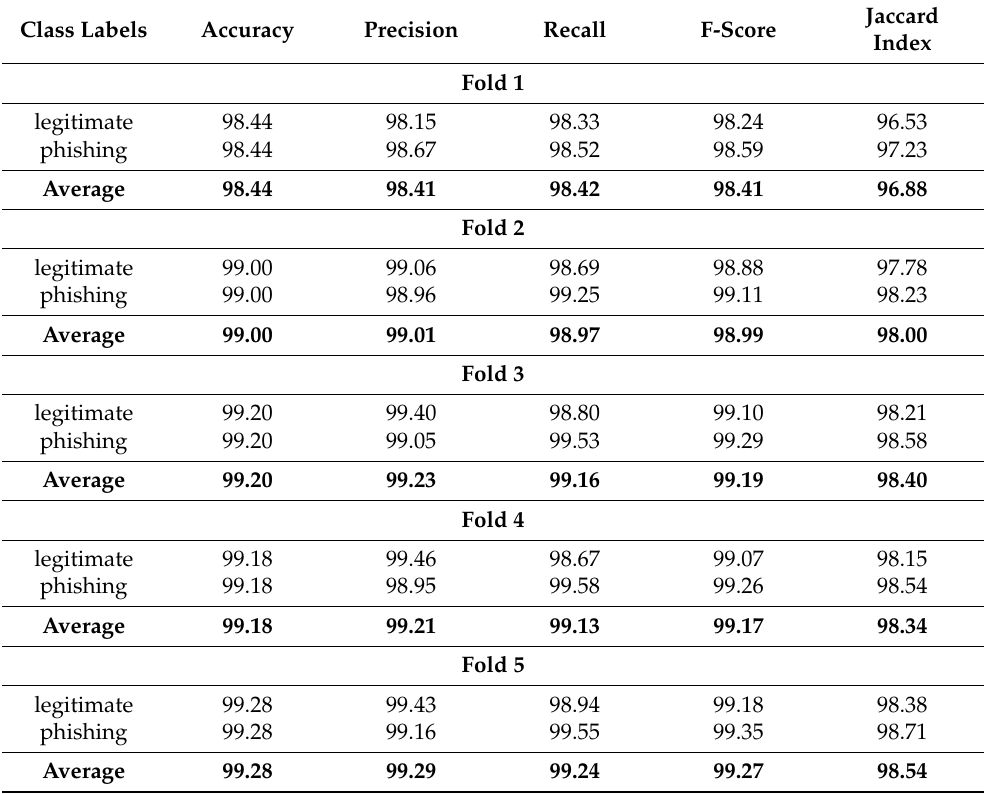
Table 2. Result analysis of ODAE-WPDC approach with various measures and